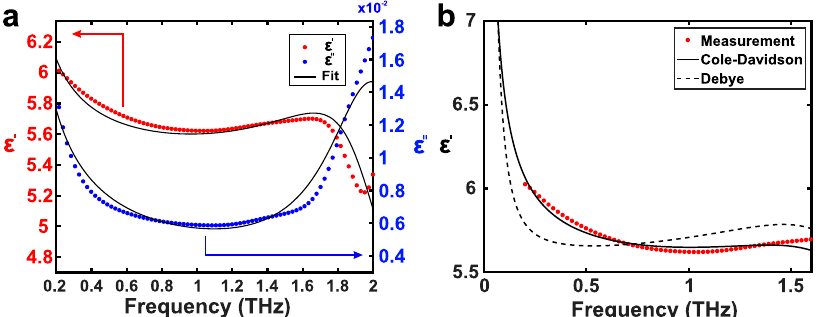
Fig. 2 THz-TDS results for CsPbBr 3 NCs dispersed in hexane. a Measured real (red) and imaginary (blue) dielectric function of CsPbBr 3 NCs from THz- TDS. The data are fi tted with Eq. (1). b Comparison of the Debye and Cole Davidson model for the real dielectric function. In this sub fi gure, both models are restricted to the low-frequency region, thereby excluding the Lorentz resonance. The Cole – Davidson fi t corresponds to τ = 21 ps and β = 0.71, giving a sum of squared residuals of 11.5, compared to 77.8 for the Debye model. Errors in the THz-TDS analysis are discussed in Supplementary Note